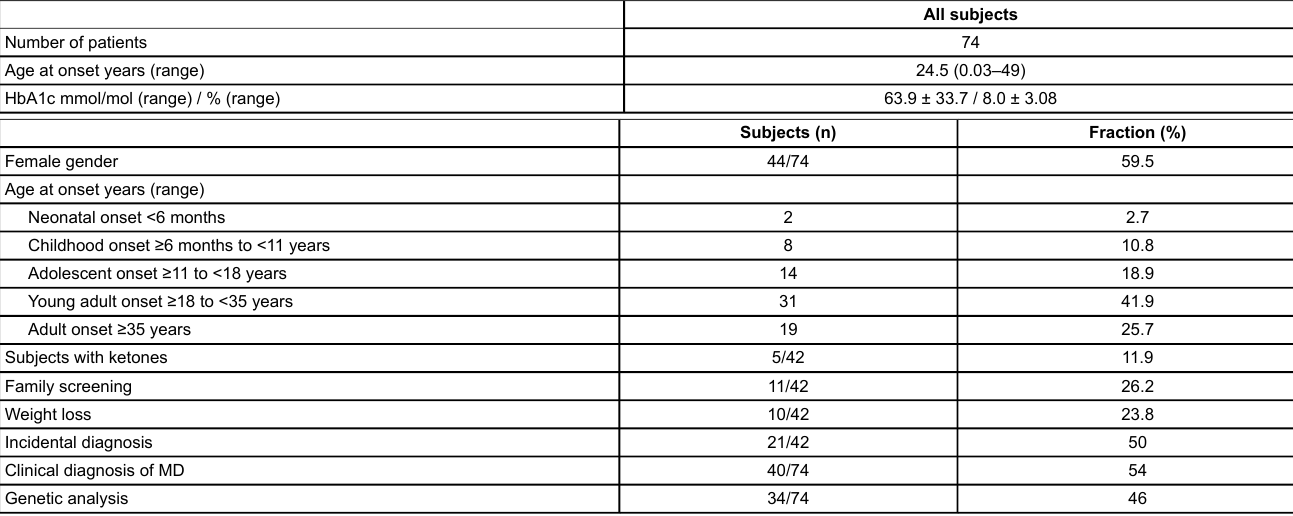
Table 1: Clinical characteristics of the subjects at diabetes onset.